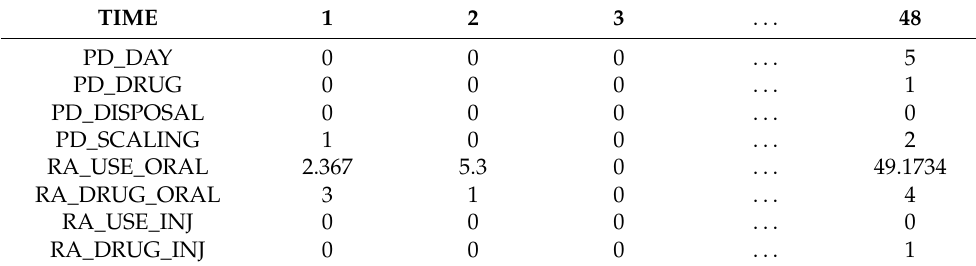
Table 6. The disease course matrix representation of the patient whose ID was 791f (k = 3).